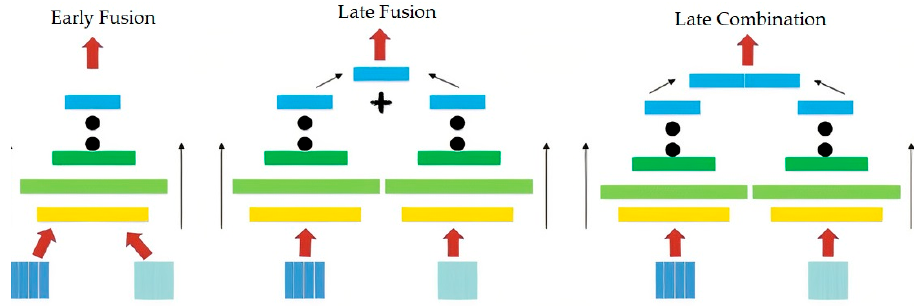
Figure 19. Different approaches used for fusing the information present in the CNN layers.